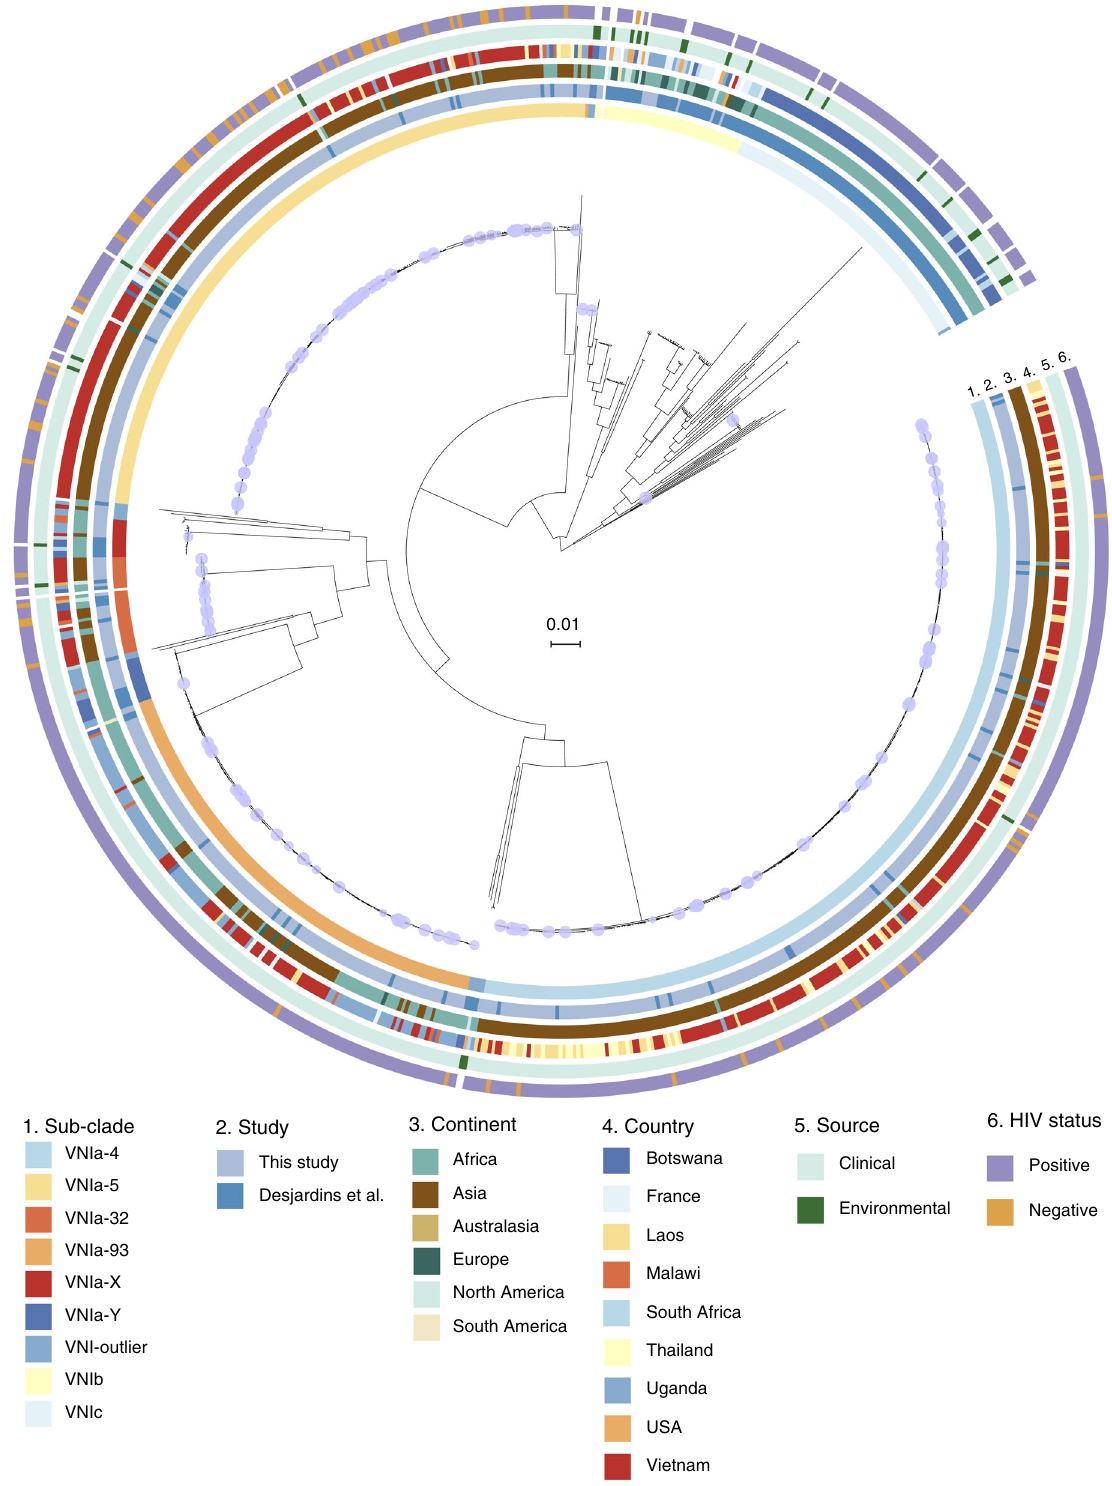
Fig. 1 A whole-genome single-nucleotide polymorphism (SNP) phylogeny of all VNI in this study and Desjardins et al. 8 , constructed from 325,812 variable positions. Nodes with <80% bootstrap support are highlighted by a blue circle. Scale bar is genetic distance in number of substitutions per (PacBio genome assemblies available via FigShare https://doi.org/ 47,619 (SD = 196), 46,218 (SD = 245) and 48,763 (SD = 262) to 10.6084/m9. fi gshare.6060686). The median SNP distance of the the H99 reference genome. VNIa-4, VNIa-5 and VNIa-93 strains to the within sub-clade reference genome was 277 (standard deviation (SD) = 142), 338 Recombination within sub-clades . Before deriving per sub-clade (SD = 236) and 361 (SD = 44) SNPs, respectively, compared with phylogenies from which genomic-epidemiological characteristics